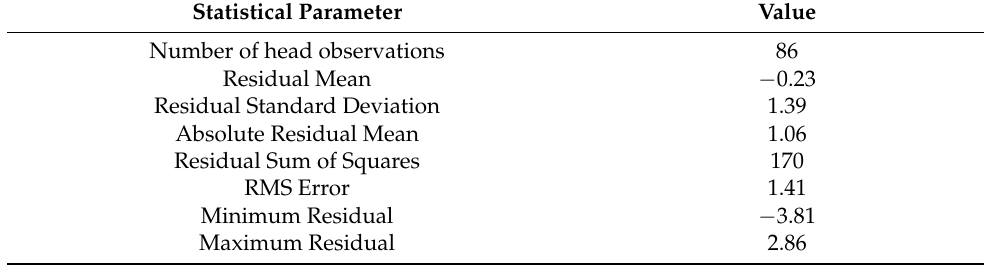
Table 6. Statistical parameters of the calibrated model.